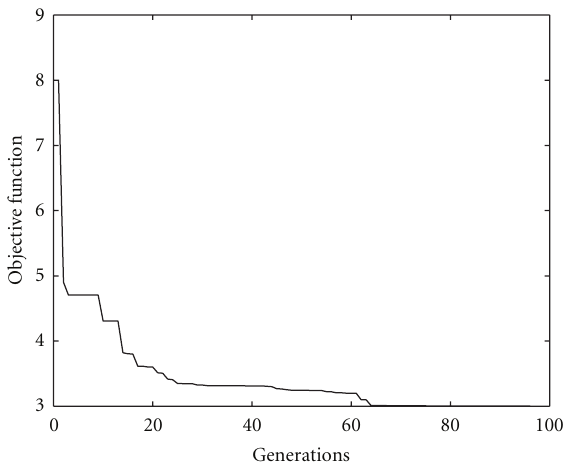
Figure 8: Convergence graph in the ACO method of the G 2 ( s ) plant.